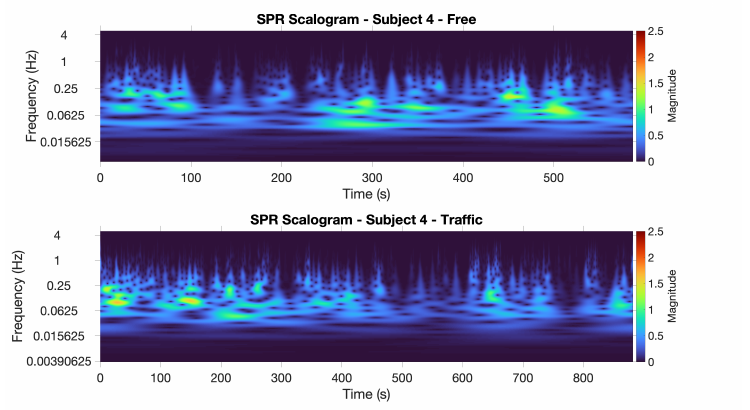
Figure 7. SPR scalograms for Subject 4: non-traffic scenario ( top ) and traffic scenario ( bottom